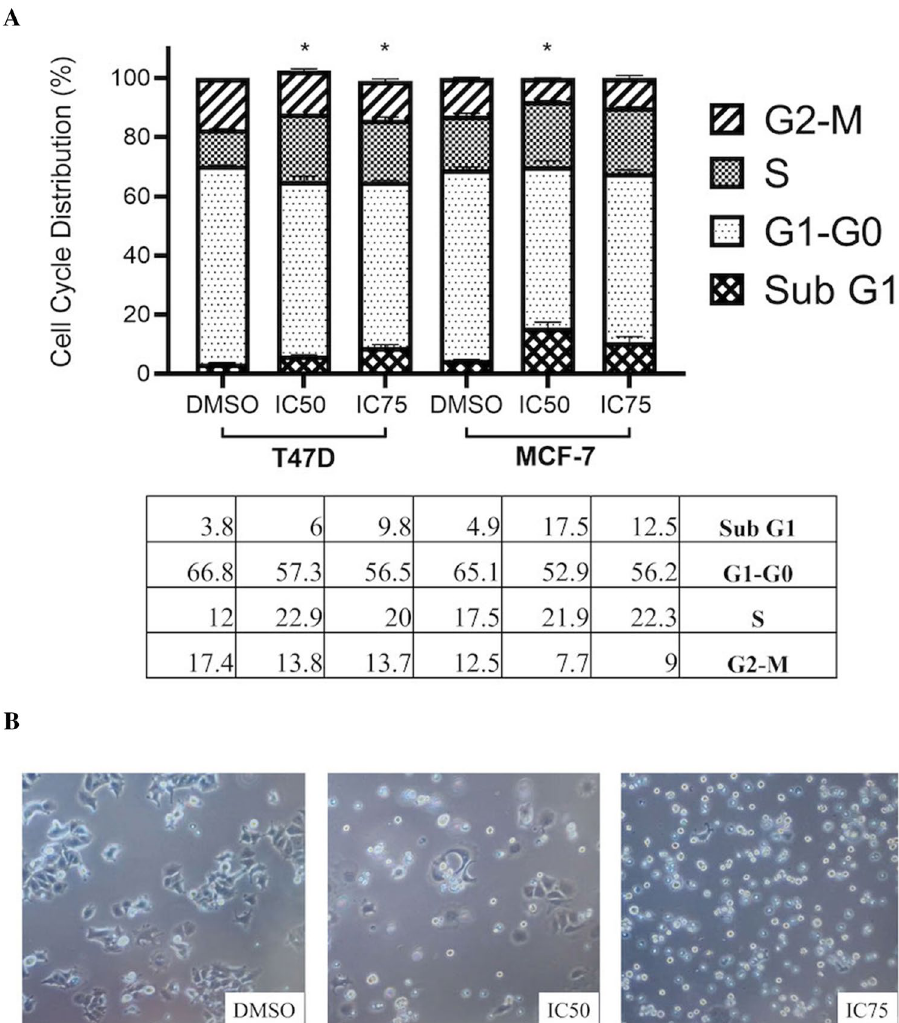
Figure 3. Cell cycle arrest and cell morphology changes induced by Averufanin. Human breast cancer cell lines MCF7 and T47D were treated with Averufanin or DMSO controls for 48 h and analyzed with flow cytometry. Bar graph shows the cell cycle stage comparison of control and treatment groups. Both treatment groups showed a significant SubG1 increase. Difference was significant compared to DMSO treated cells for SubG1 ( A ) (*p < 0.05) The brightfield microscopy image shows MCF-7 cell line treated with its respective DMSO Control, IC 50 and IC 75 doses. (×10 magnification) ( B ) 1 × 10 5 cells were seeded in 6-wells for PI Cell Cycle Assay, images were taken before collection of cells. Cells undergoing apoptosis looks detached from the surface and spherical, whereas attached cells showed no apparent morphology